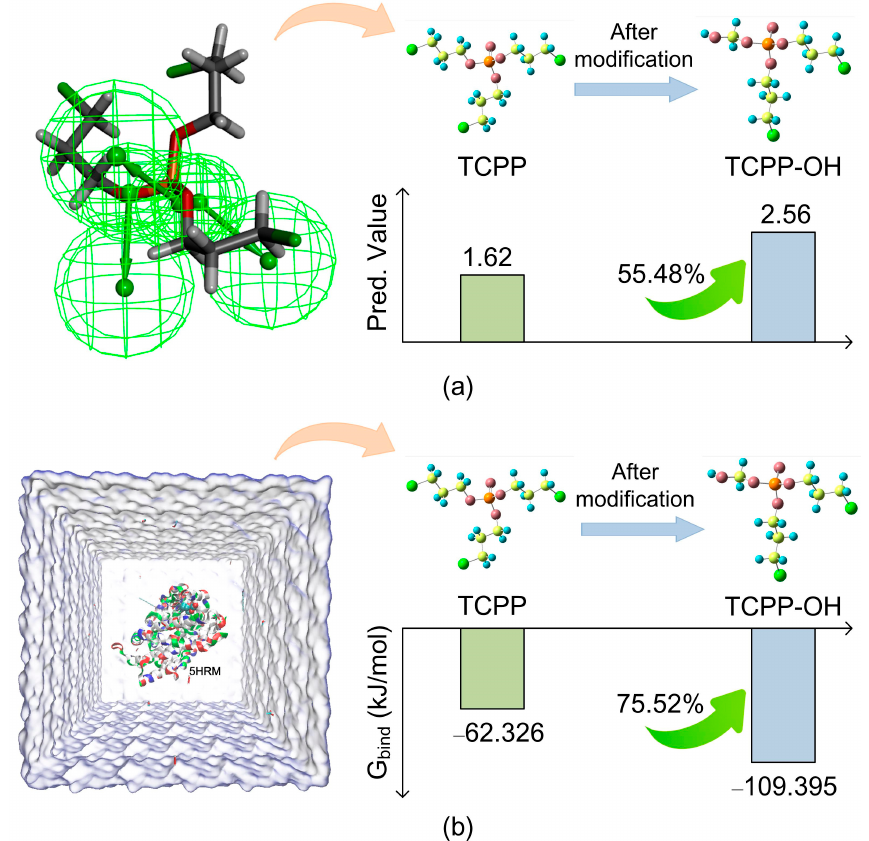
Figure 6. Diagram for the comparison of biodegradation efficiency of TCPP–OH using ( a ) biodegradation pharmacophore model prediction and ( b ) molecular dynamic simulation.